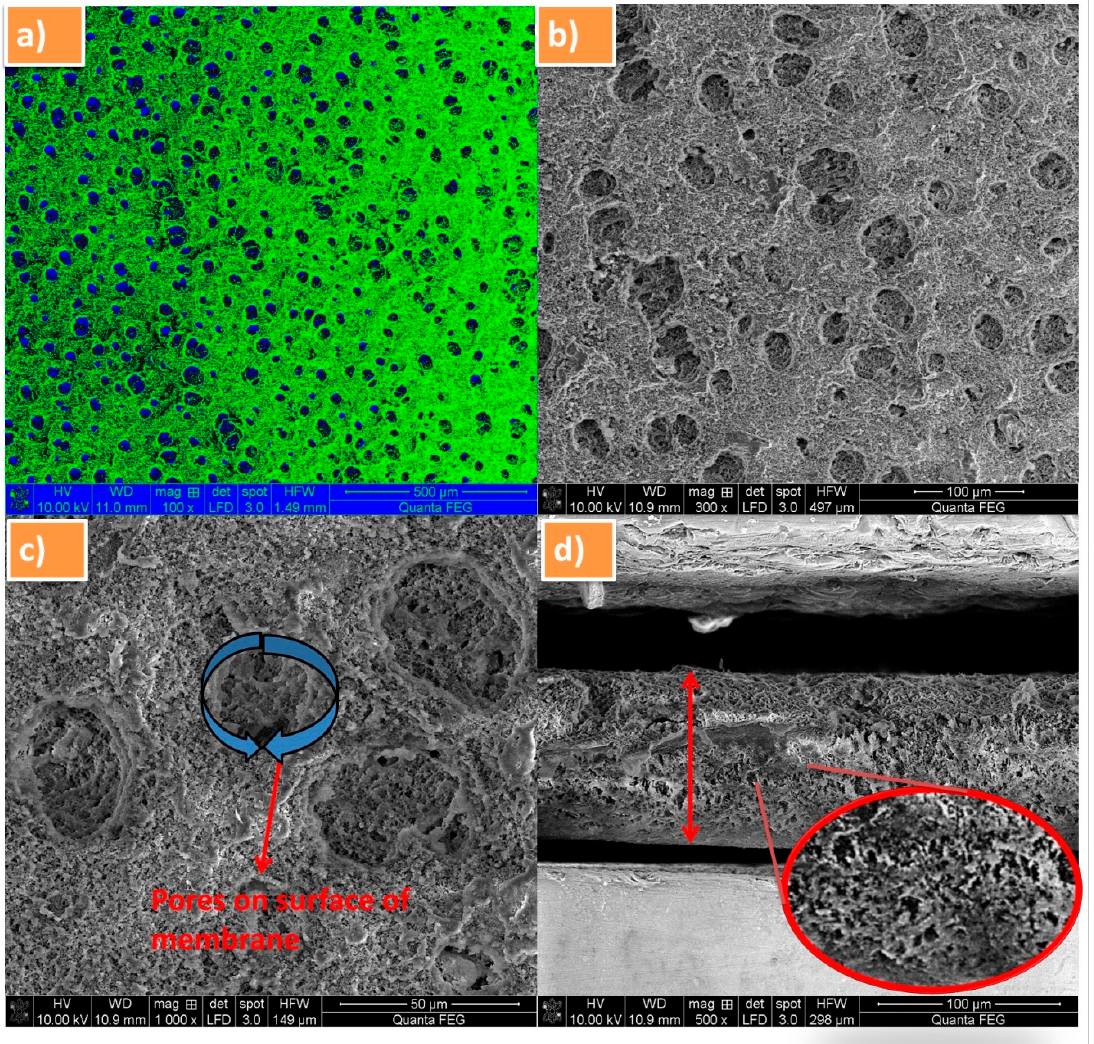
Figure 3. FE-SEM images of PVdF-SiO 2 membrane ( a ) color overlaid SEM image, the blue and green colors indicate the pores and surface of membrane, respectively; ( b ) separator at 300 × magnification; ( c ) visible pores on the membrane surface; and ( d ) cross-sectional FE-SEM view of membrane with enlarged area view.